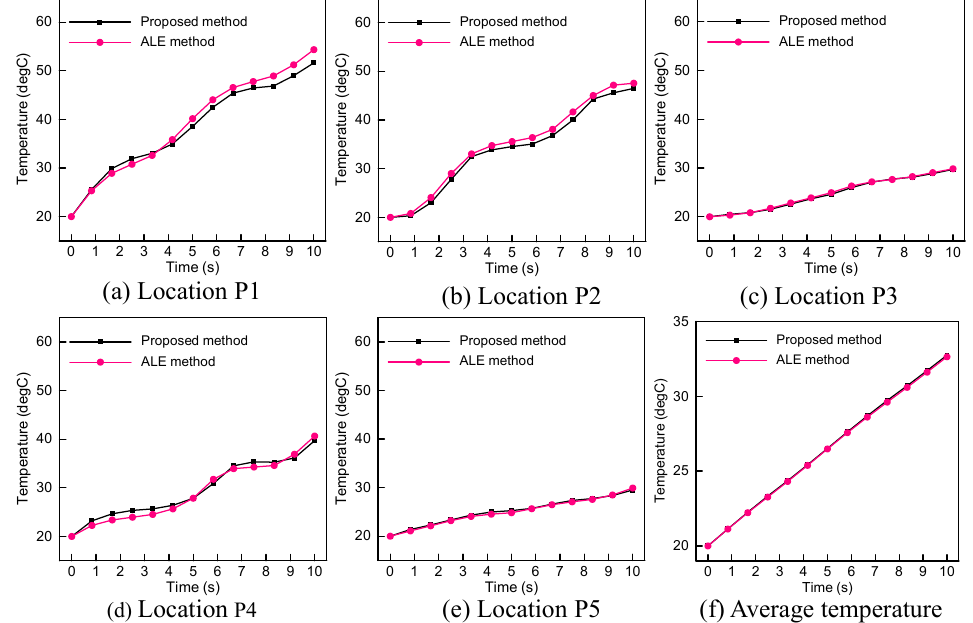
Figure 8. Comparison of the time-dependent temperature calculated by the proposed method and the ALE method at the five specific points.